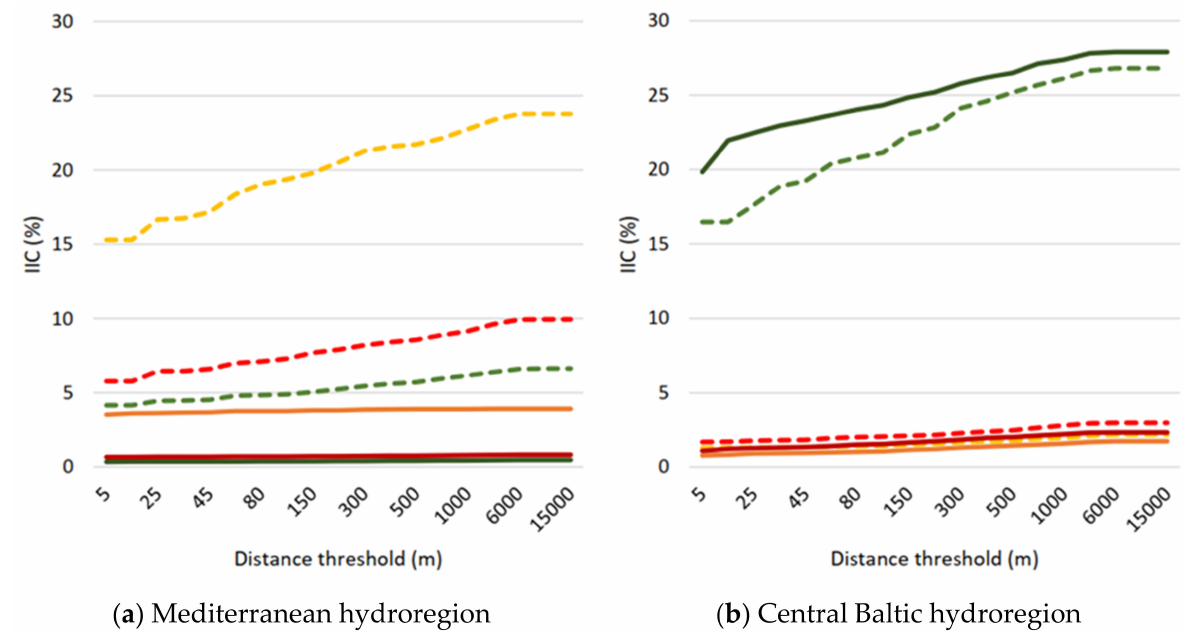
Figure 3. Integral Index of Connectivity (IIC) (%) with incremental distance thresholds (m) along the gradient of human disturbance (dashed lines—Copernicus Actual Riparian Zone (ARZ); solid lines—Manual Riparian Zone (MRZ); green lines—Least Disturbed Sampling Units (SUs); orange lines—Moderately Disturbed SUs; Red lines—Highly Disturbed SUs) for the ( a ) Mediterranean and ( b ) Central Baltic